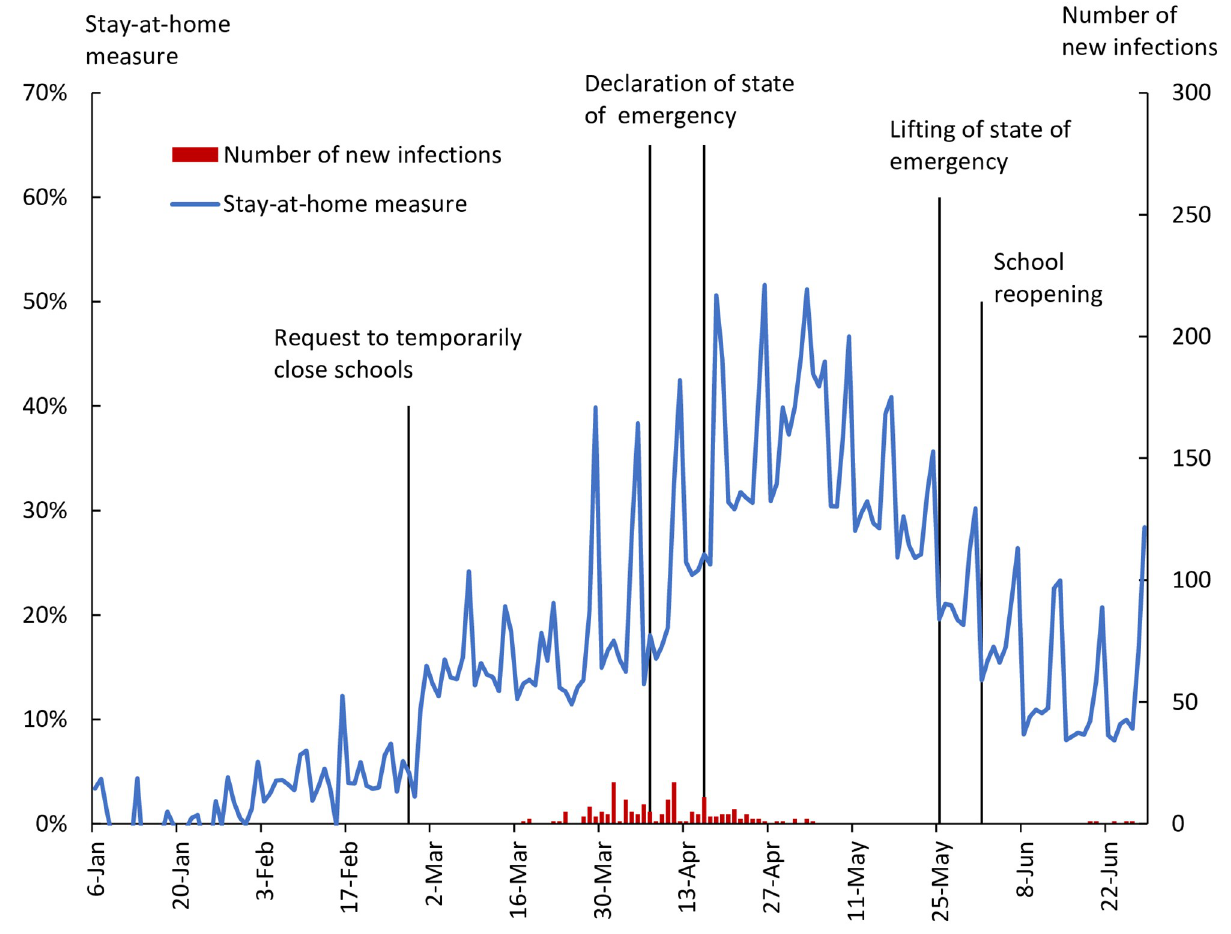
Fig 2. Stay-at-home measure and number of new infections,